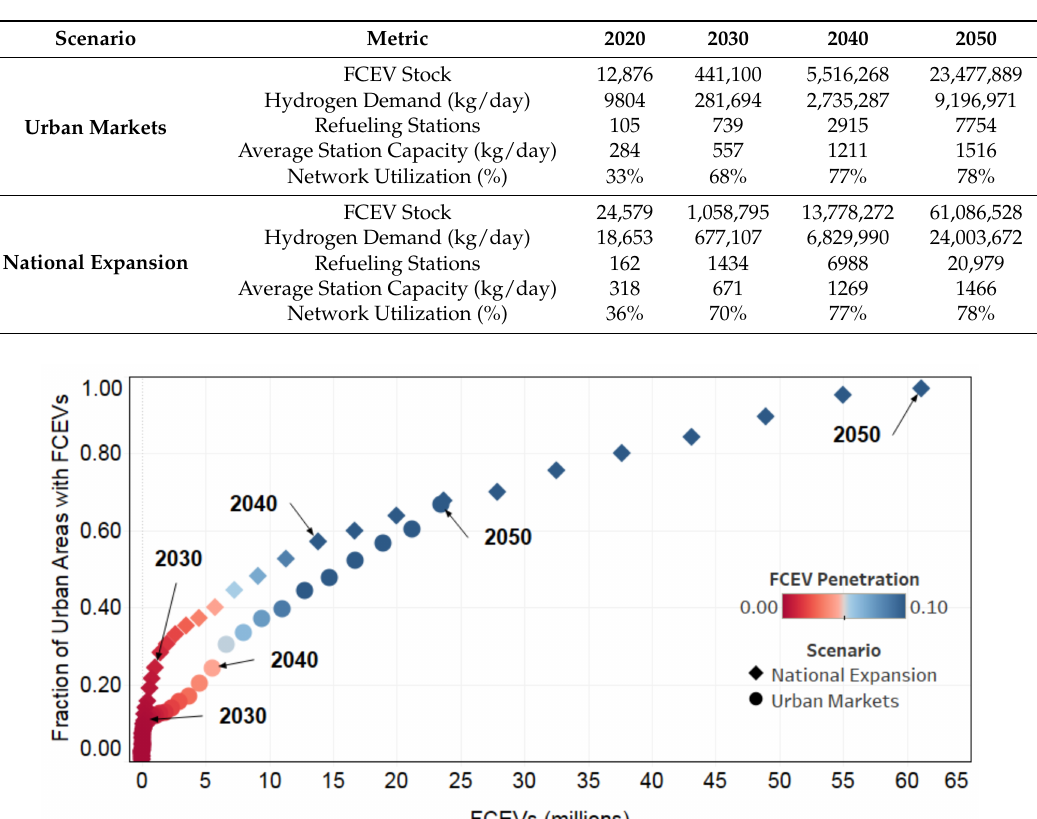
Table 2. FCEV adoption, hydrogen demand, and hydrogen refueling stations summary data.